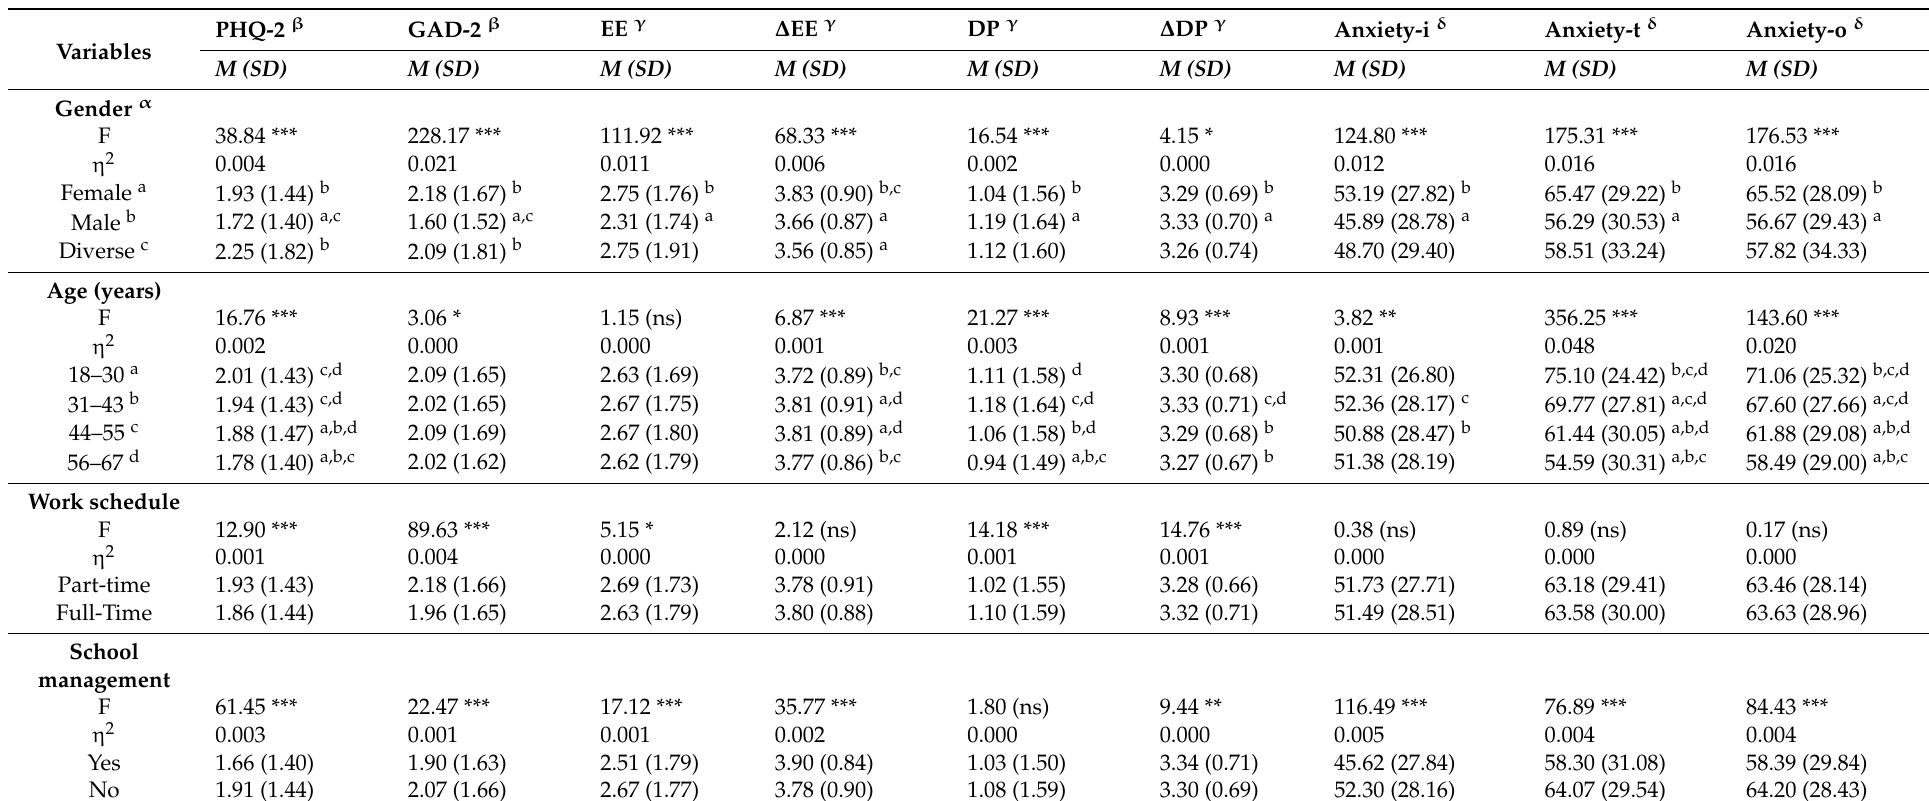
Table 2. Psychological burdens in different subgroups of German teachers during the SARS-CoV-2